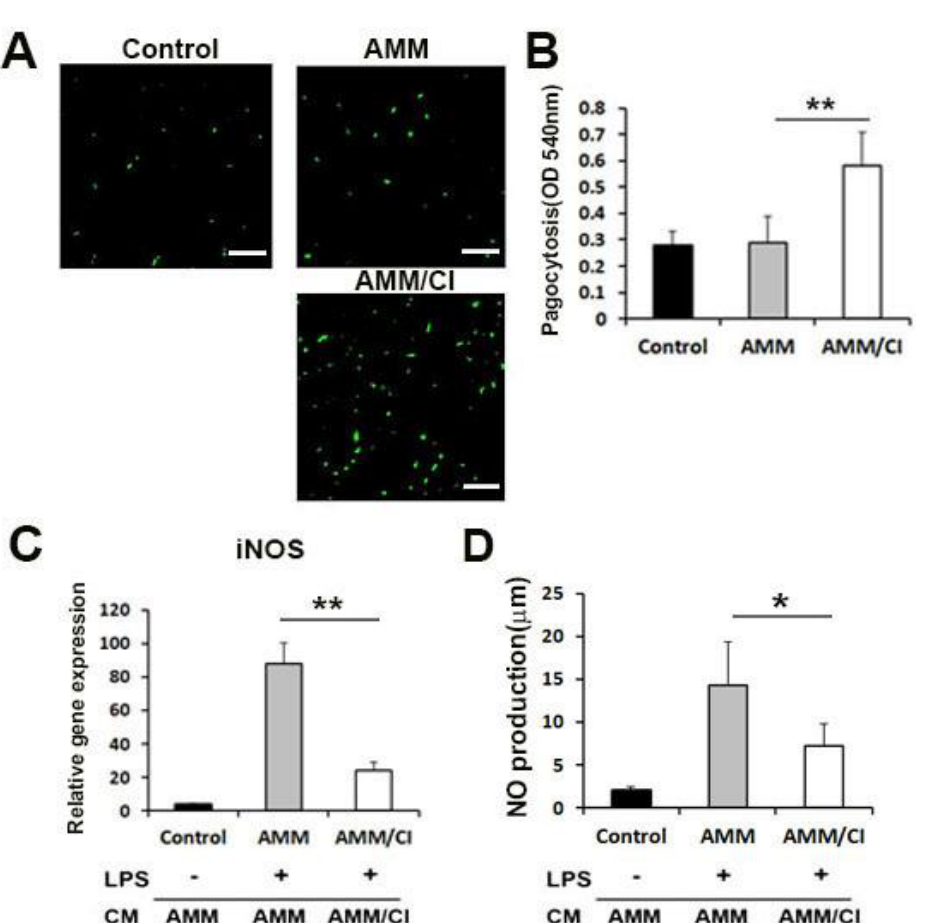
Figure 3. Phagocytosis and in vitro anti-inflammatory potential of secreted factors derived from AMM/CI. ( A ) Representative images of engulfing the fluorescent beads (green) in RAW 264.7 after treatment of vehicle control, CM of AMM, or AMM/CI. AMM/CI CM-treated cells exhibited high capacity in engulfing the fluorescent beads compared with the control or AMM CM group. Bars = 200 μ m. ( B ) The neutral red experiment was performed to evaluate the effects of CM on the phago- cytic potential of RAW 264.7. The neutral red experiment showed that the absorbance values of the RAW 264.7 were significantly higher in CM of AMM/CI than that of AMM or control group. ** p < 0.01, n = 5 per group. ( C ) The effect of AMM/CI CM on LPS-induced iNOS mRNA in RAW 264.7 cells. ** p < 0.01, n = 5 per group. ( D ) The effect of AMM/CI CM on LPS-induced NO production in RAW 264.7 cells. Cells were pre-treated with CM of each cell for 12 h and then incubated with LPS for 18 h. The amount of NO was measured by the Griess method. * p < 0.05, n = 5 per group.